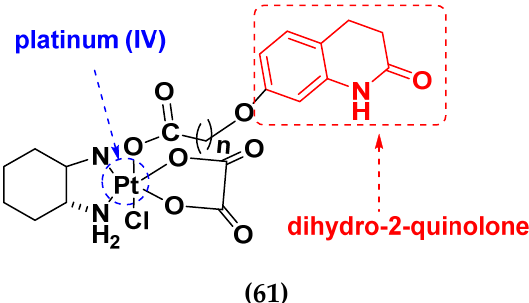
Figure 64. Structure of Platinum (iv) dihydro-2-quinolone hybrid derivatives ( 61 ). Table 51. In vitro cytotoxic activities of Platinum (iv) dihydro ‐ 2 ‐ quinolone hybrid compounds 61 ( a – c ).